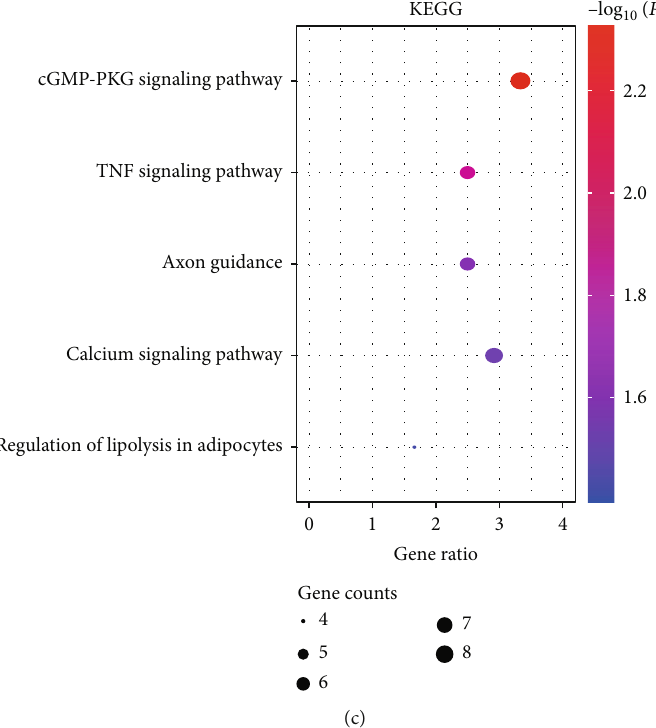
Figure 7: Biological functions analyses of the predicted target genes of miRNA-33a-5p. (a) Venn diagram of overlapping genes from the intersection of two independent datasets. (b) GO enrichment analysis bubble diagram. (c) KEGG pathway enrichment analysis bubble diagram. The x -axis represents the numbers of involved genes, and the y -axis represents the GO and KEGG terms. Each bubble represents a term. The size of the bubble indicates the number of involved genes. Red indicates higher degrees of signi fi cance of gene enrichment analysis than blue. DEGs: di ff erentially expressed genes; GO: Gene Ontology; KEGG: Kyoto Encyclopedia of Genes and Genomes; BP: biological process; CC: cellular component; MF: molecular